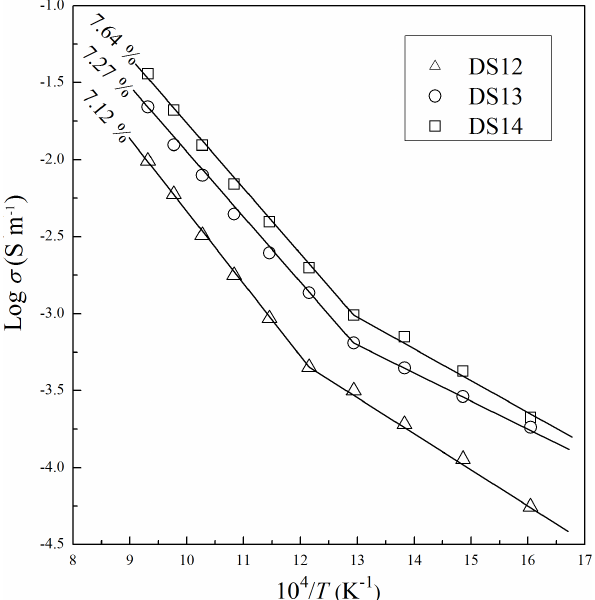
Figure 7. Logarithm of the electrical conductivities versus the re- ciprocal temperatures of the gneiss samples with various chemical compositions at 1.5GPa and 623–1073